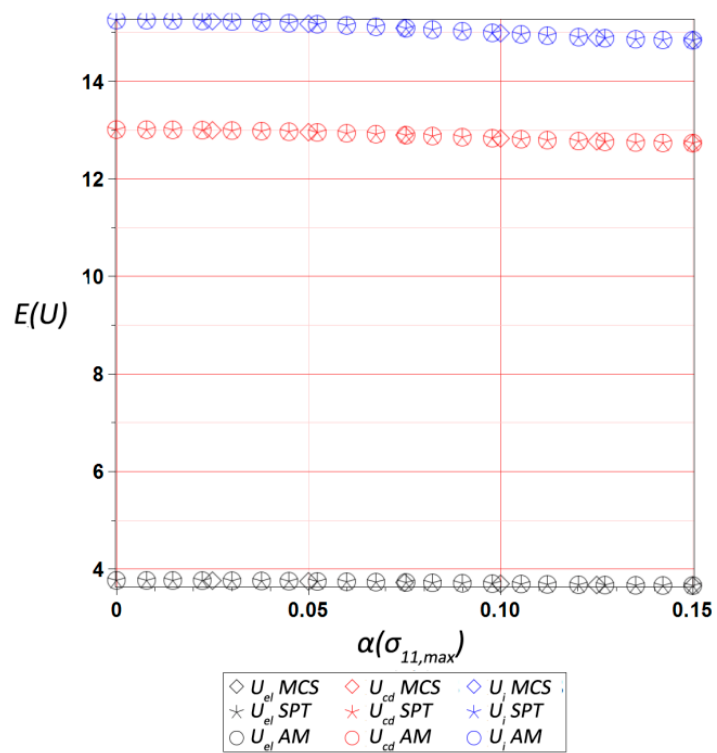
Figure 9. Expected value of the ultimate elastic strain U el , dissipation U cd , and internal U i energies in σ the RVE vs. α 11, max .